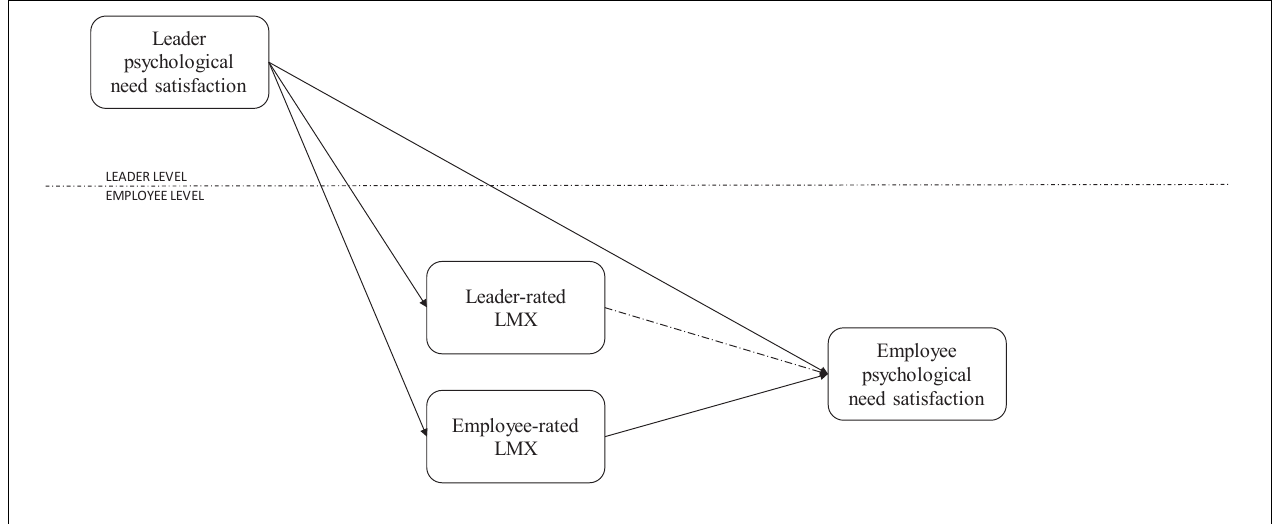
FIGURE 1 | Research